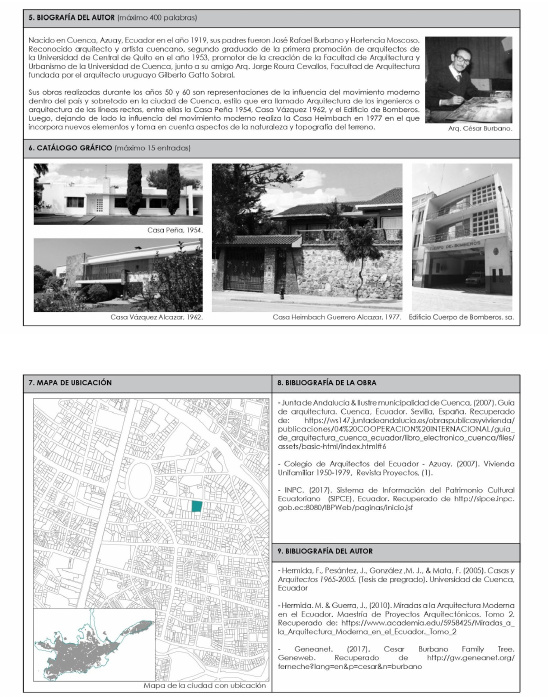
Figure 12: Documentation fiche for modern architecture in Cuenca, application in “La Casa